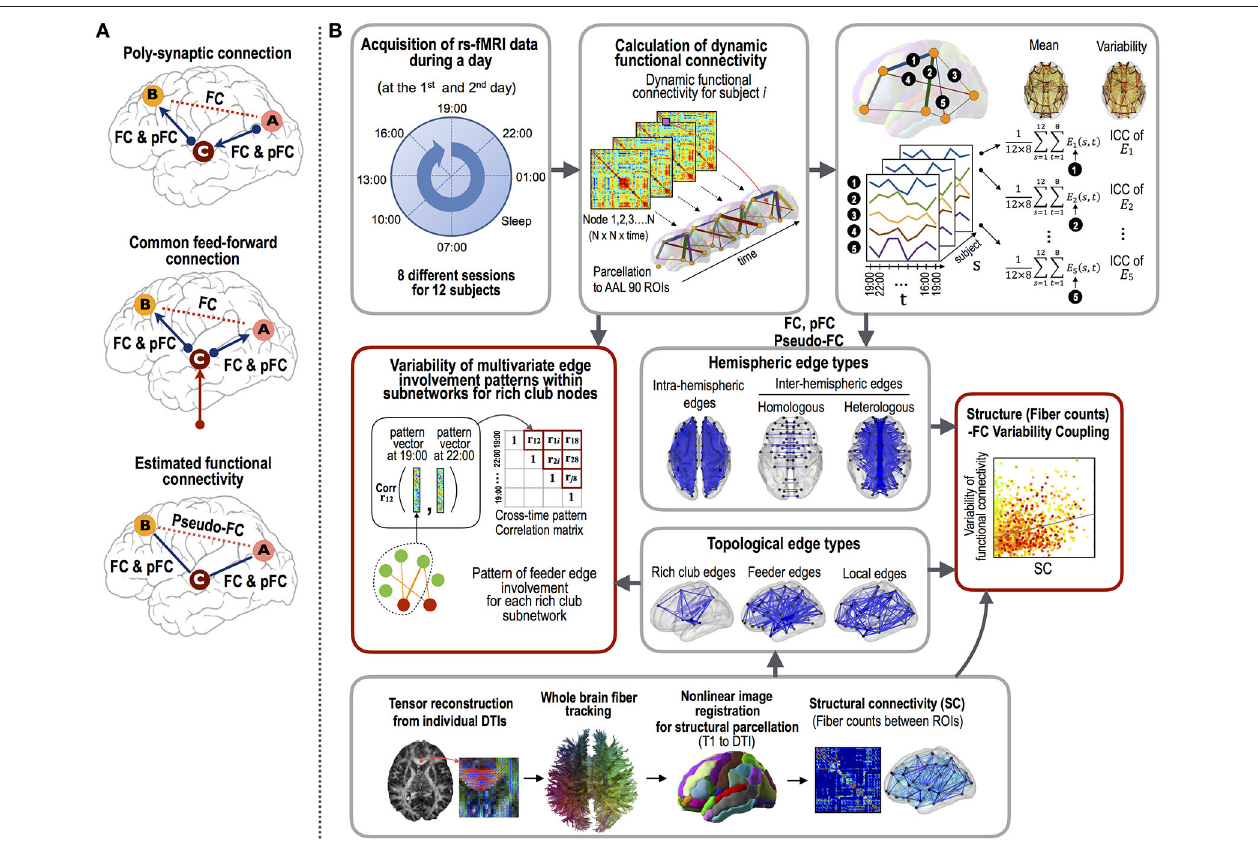
FIGURE 1 | The procedures employed for the functional connectivity variability analysis. (A) The three types of functional connectivity: FC, pFC, and pseudo-FC. Functional connectivity was defined by Pearson correlation coefficient (FC) and partial correlation (pFC). Pseudo-functional connectivity (pseudo-FC) was defined as the difference between FC and pFC, i.e., the edges where FC exists but pFC does not. Pseudo-FC can be derived with polysynaptic connections or common feed-forward projections without direct interactions between two regions. (B) The analyses used in this study were as follows: (1) the acquisition of resting state fMRI data at eight different time points during a day and DTI data, (2) calculation of three types of functional connectivity (i.e., FC, pFC, and pseudo-FC) and structural connectivity (i.e., log-transformed fiber counts), (3) correlation analyses between intra-class correlations (ICCs, stability) of the functional connectivity and structural connectivity according to edge properties (fiber counts and lengths), edge types (intra-hemispheric and inter-hemispheric homologous and heterologous edges), and topological edge types under rich club architecture, and (4) evaluations of the multivariate edge involvement pattern similarity under the rich club architecture. The multivariate pattern similarity was evaluated by calculating the average similarities of the connectivity matrices within subnetworks of the rich club nodes across the different time points within a day. Note that variability was evaluated with similarity measures